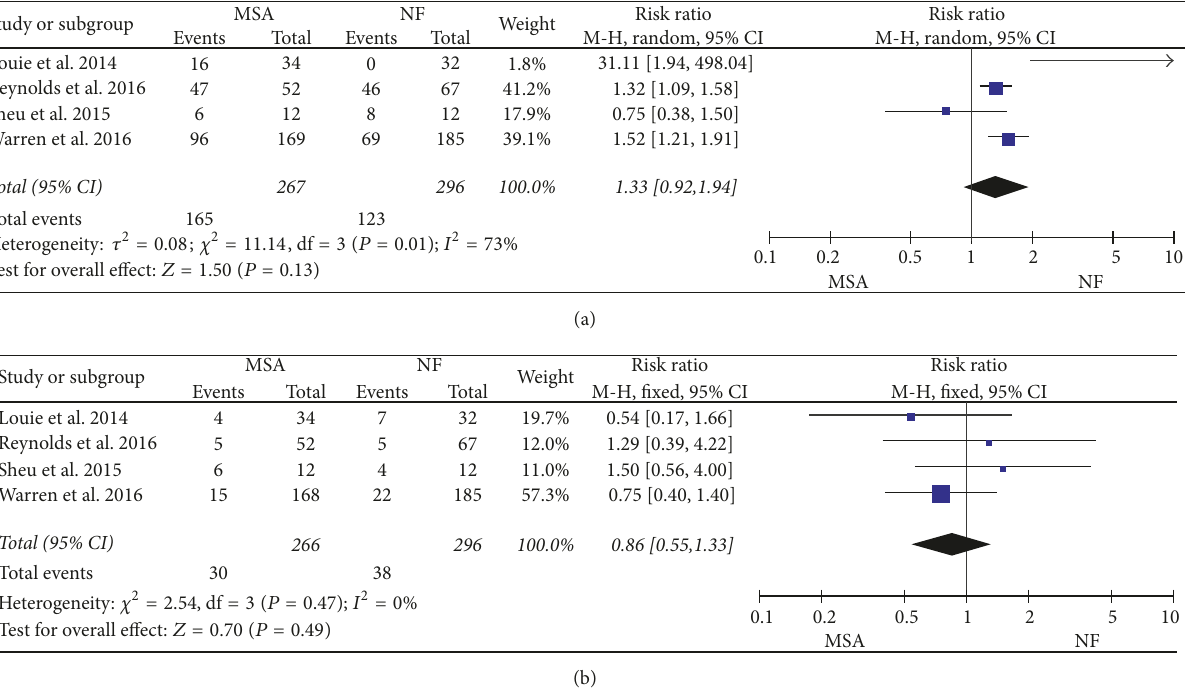
Figure 3: Forest plot of studies evaluating risk ratios of the number of complications (a) and severe dysphagia for dilation